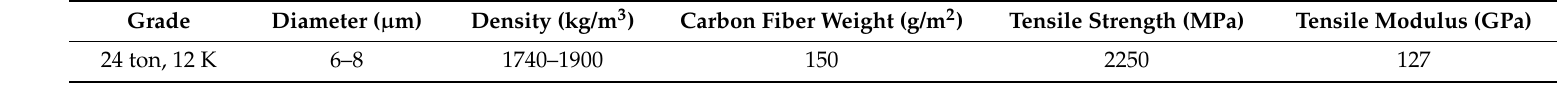
Table 1. Physical properties of carbon fiber.